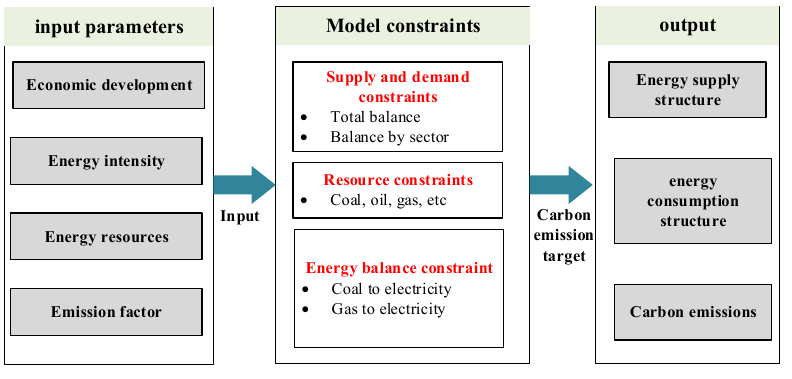
Figure 1. Model framework.